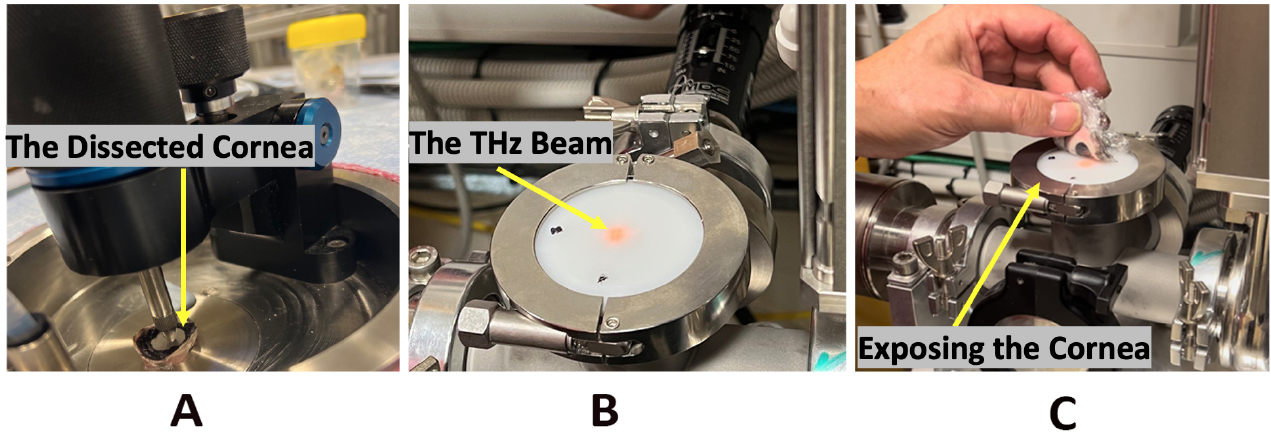
Figure 2. The illustration of the experimental setup ( A ) The examination of the porcine cornea immediately after dissection and before THz exposure using the ATR system ( B , C ) the THz/Far-IR beamline at the Australian Synchrotron was used as a radiation source to irradiate the samples. The THz beam is invisible, and by the interaction of the beam with the Teflon plastic, a patch of red light is produced. (The beam is combined of THz/Far-IR and the interaction of the IR portion with the Teflon excites into the red